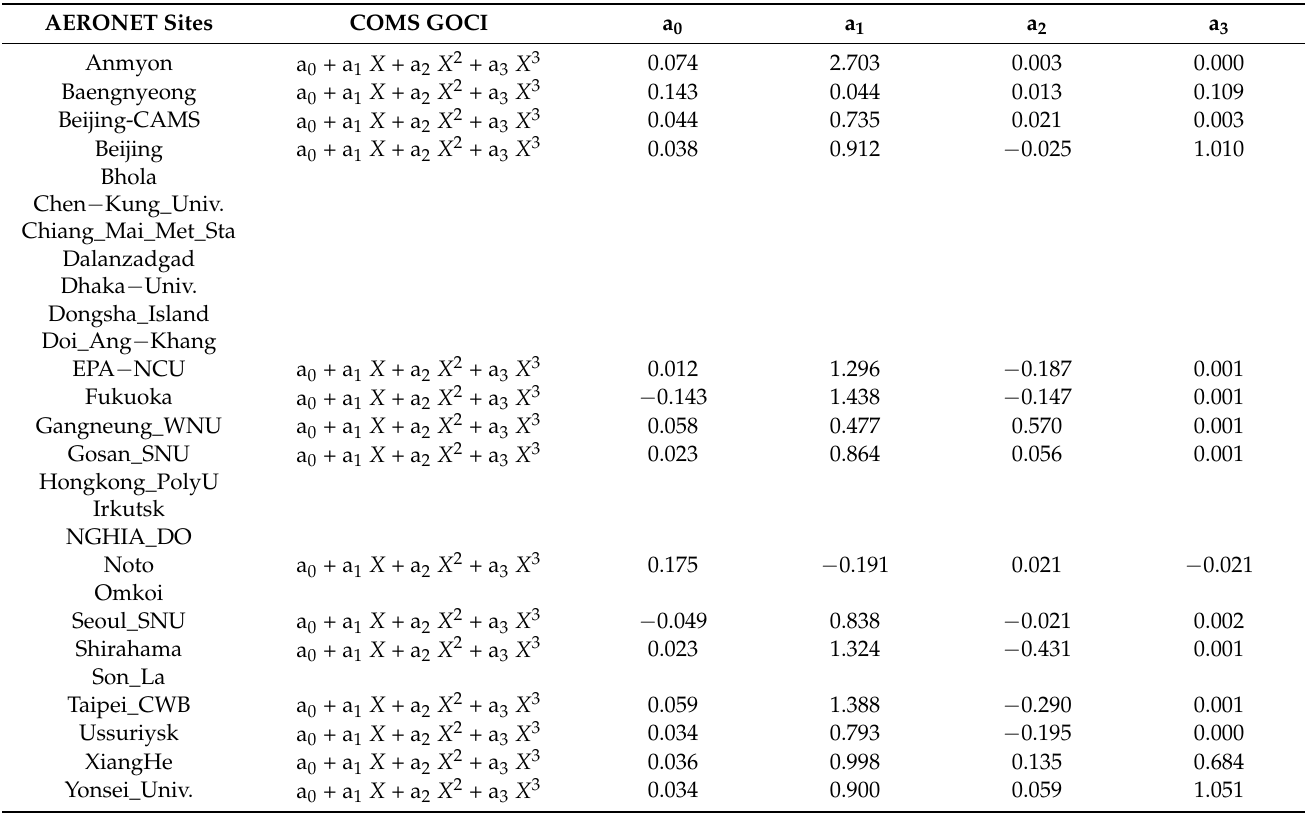
Table A2. Summary coefficients of COMS/GOCI AOD products during 2016 in training data ( X = AOD ). AERONET Sites